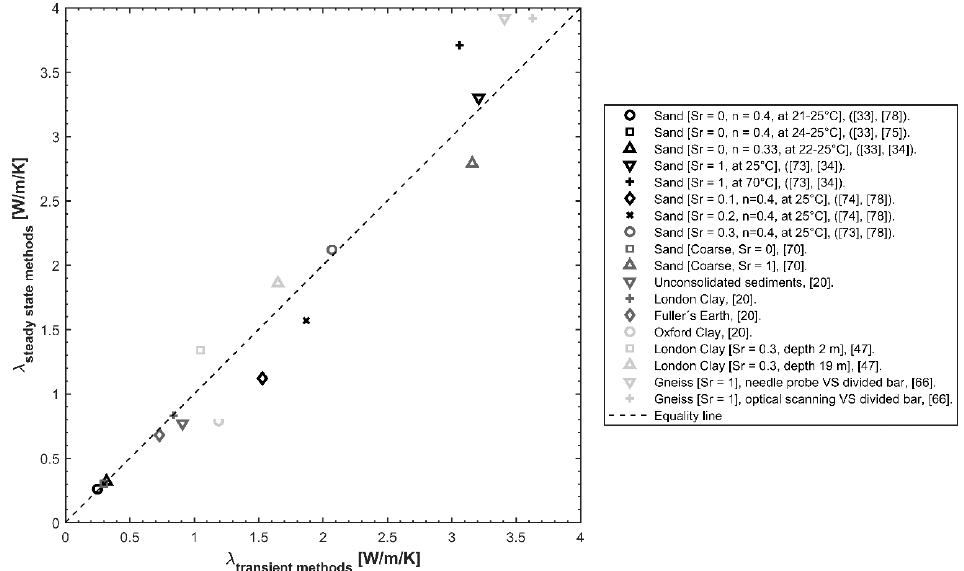
Figure 8. Comparison of transient and steady-state derived thermal conductivity ( λ ) values based on